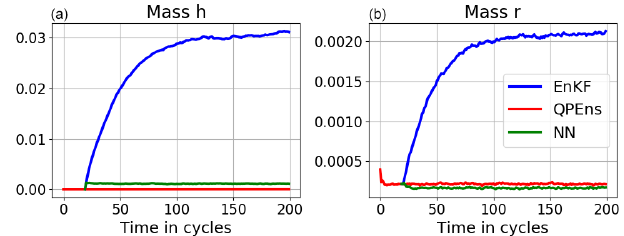
Figure 7. The same as Fig. 4 but for dT10 η = 2 .